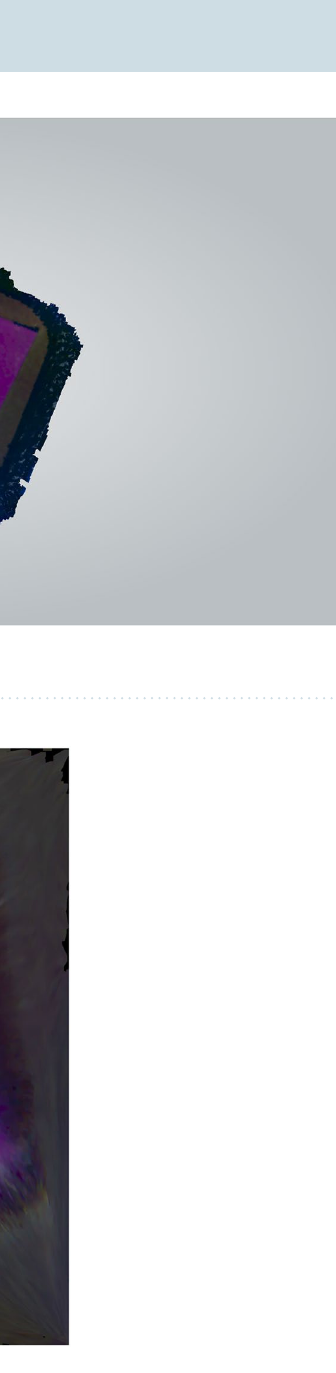
Figure 4. Texture image captured by the intra oral scanner. The green circle marks the area selected for RGB